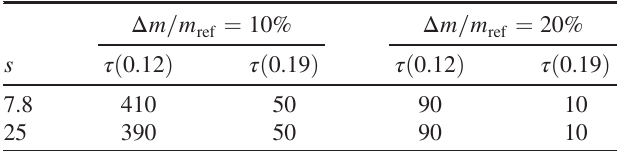
TABLE III. Specific values of the estimated number of Þ , for two lattice depths with experimental realizations, τ ð m ref κ ¼ 1 . 05 presented in Fig. 18(b). The parameters of the block are given in Table I. Here, m is the RPA corrected order parameter ref (Sec. IV D 1).